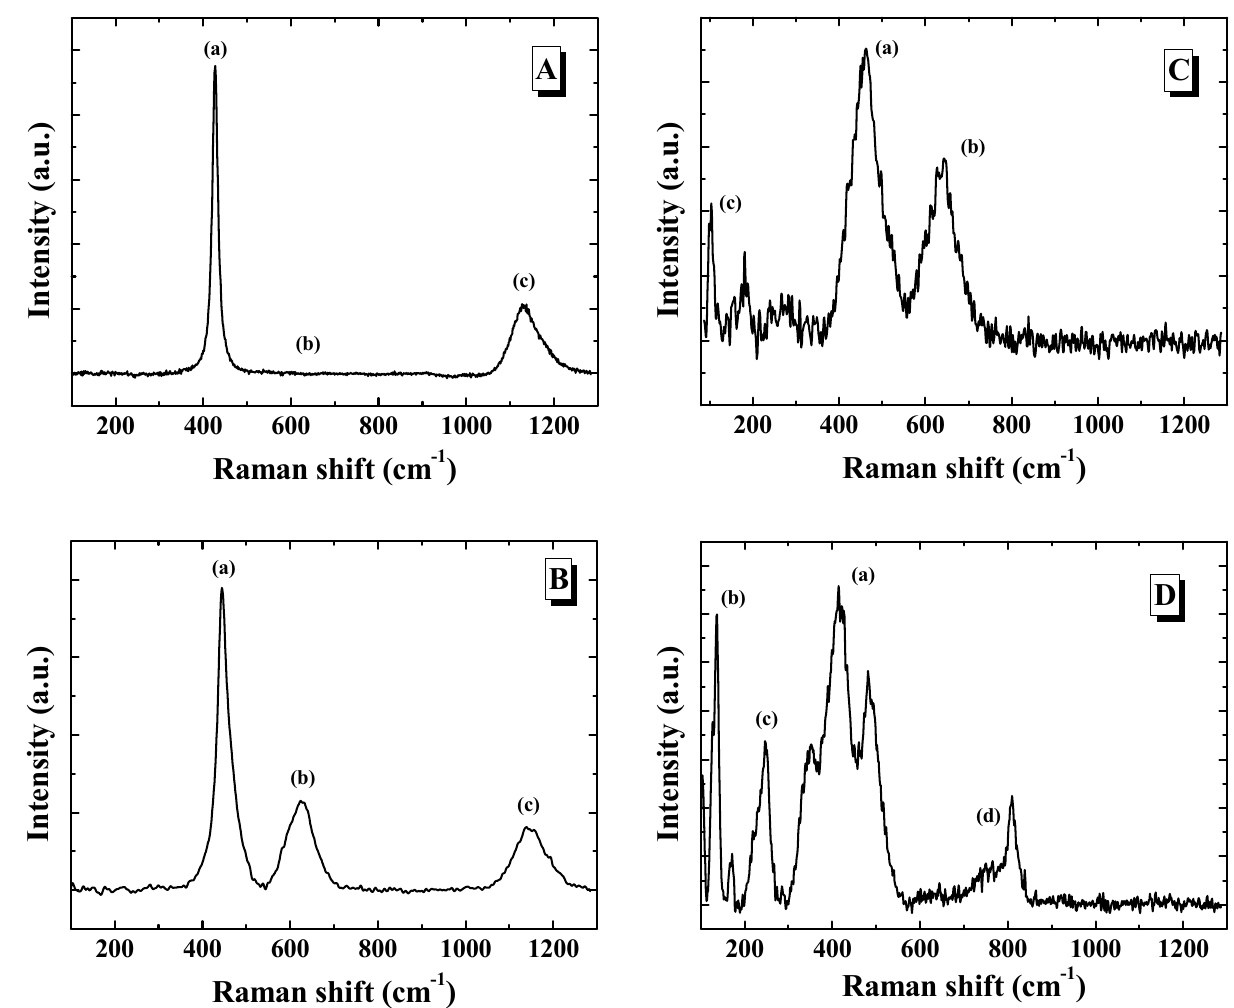
Figure 1. Raman signatures of the different uranium oxides characterized in this work, being ( A ) UO 2 ( B ) UO 2+x (UO 2.10 ) ( C ), U 3 O 7 and ( D ) U 3 O 8